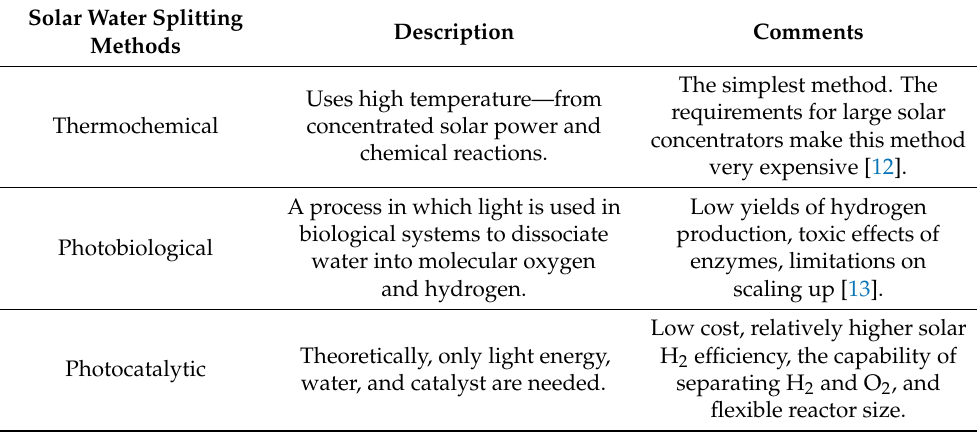
Table 1. Summary of solar water splitting